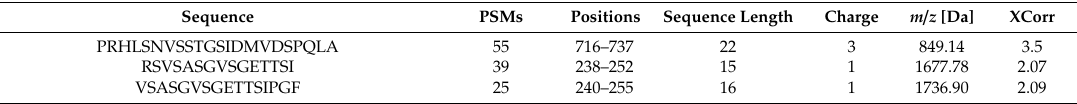
Table 4. Selected rat tau-733 peptides from rat primary cultures conditioned media identified by nLC-MS / MS. Sequence PSMs Positions Sequence Length Charge m / z [Da] XCorr PRHLSNVSSTGSIDMVDSPQLA